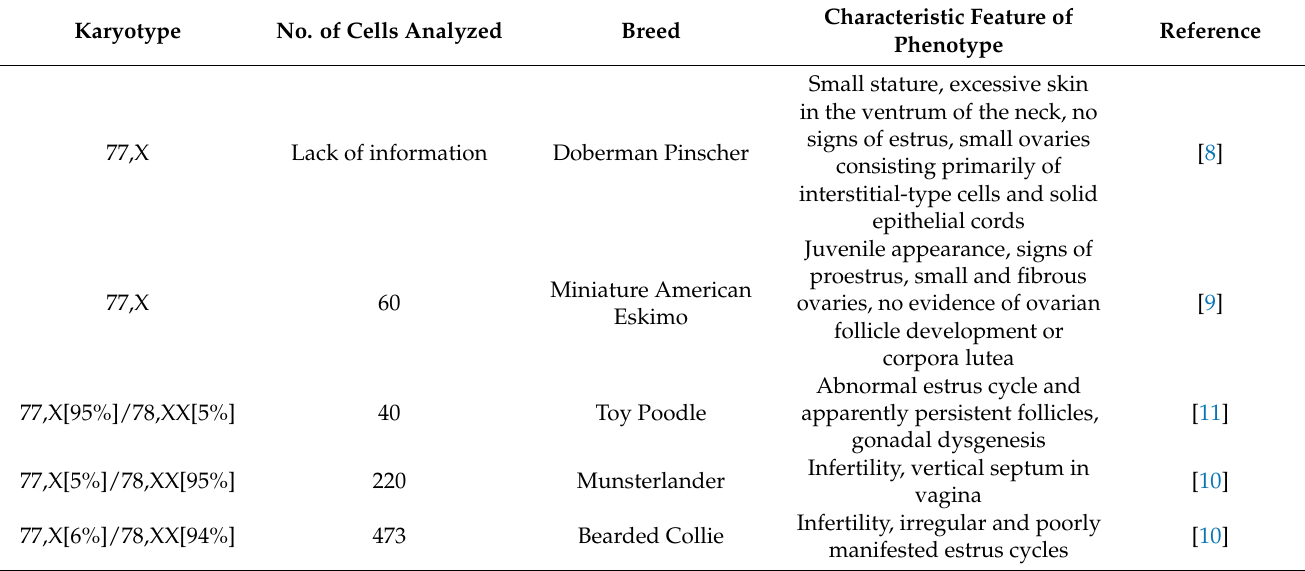
Table 1. Cases of X monosomy reported in dogs.